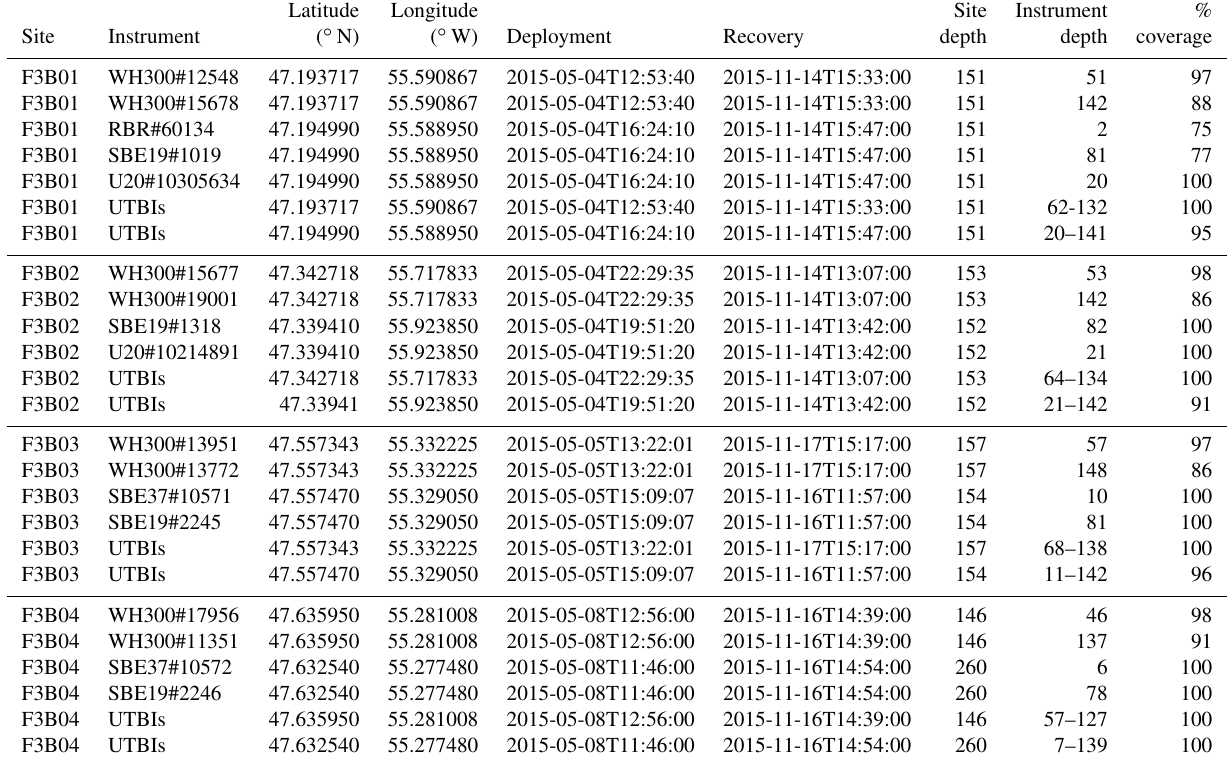
Table B1. Data collection summary, leg 1 (May–November